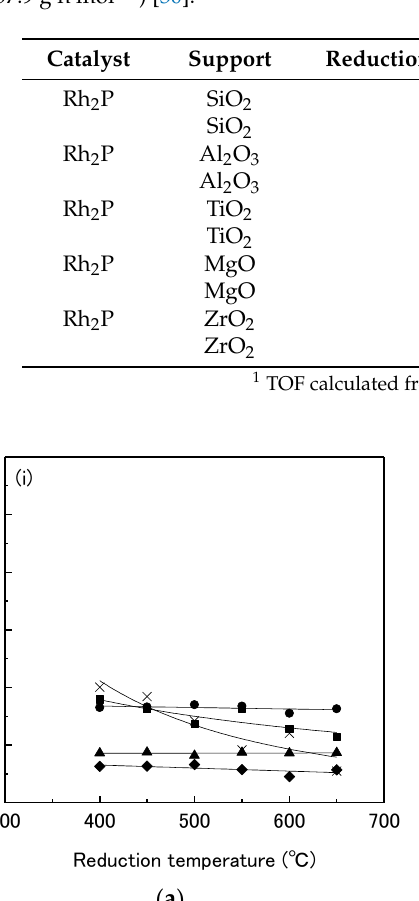
Table 7. Effect of the reduction temperature on the TOF of the Rh 2 P catalyst materials in the HDS of thiophene (fixed-bed reactor, 0.1 g catalyst, 350 ◦ C, 0.1 MPa, H 2 /thiophene = 30, W/F = 37.9 g h mol − 1 ) [30].